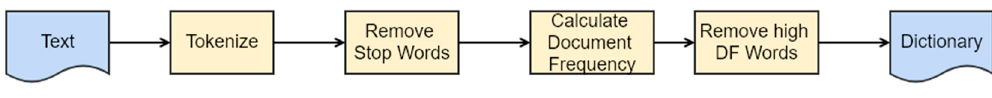
Figure 4. Dictionary initialization.